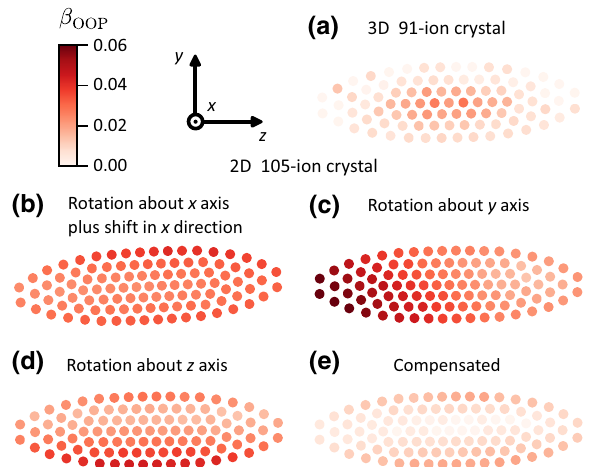
FIG. 2. Measurement of the micromotion modulation index in the out-of-plane direction. (a) A 91-ion crystal is used to investi- gate planarity. In this example, ions in the center of the crystal display a higher modulation index as they are pushed out to the third dimension. (b)–(d) Examples of planar 105-ion crystals displaying various undesirable scenarios where shifts along and rotations about arbitrary axes are present, leading to increased micromotion modulation indices. The labels indicate the main contribution to the crystal misalignment. (e) By applying precal- culated sets of dc voltages, we are able to compensate for shifts and rotations and align the ion crystal with the trap center and principal axes such that the micromotion modulation indices are minimized for all